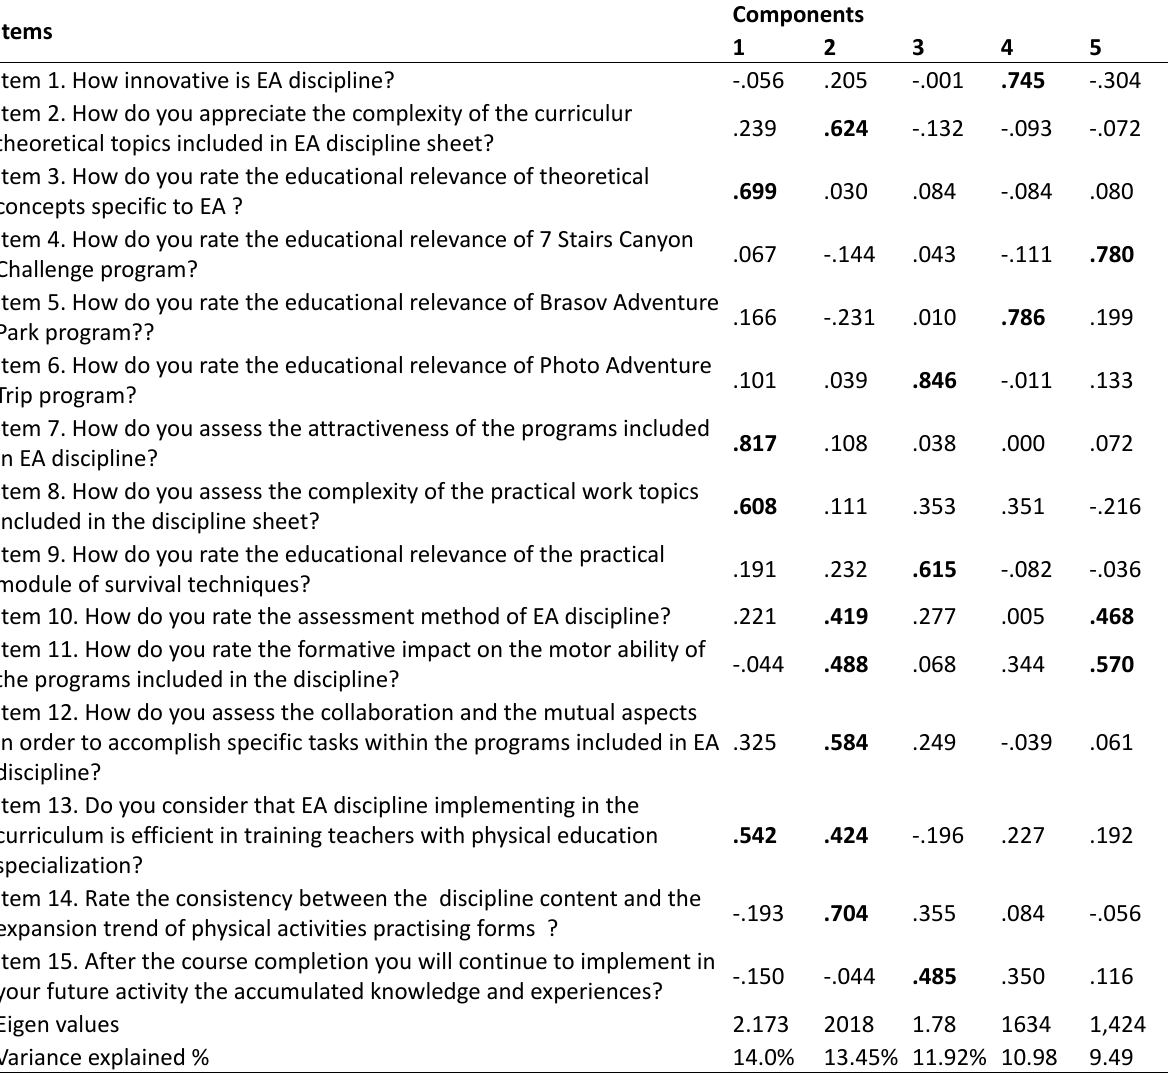
Table 3 . Items Relevance for the 5 identified patterns - Rotated Component Matrix